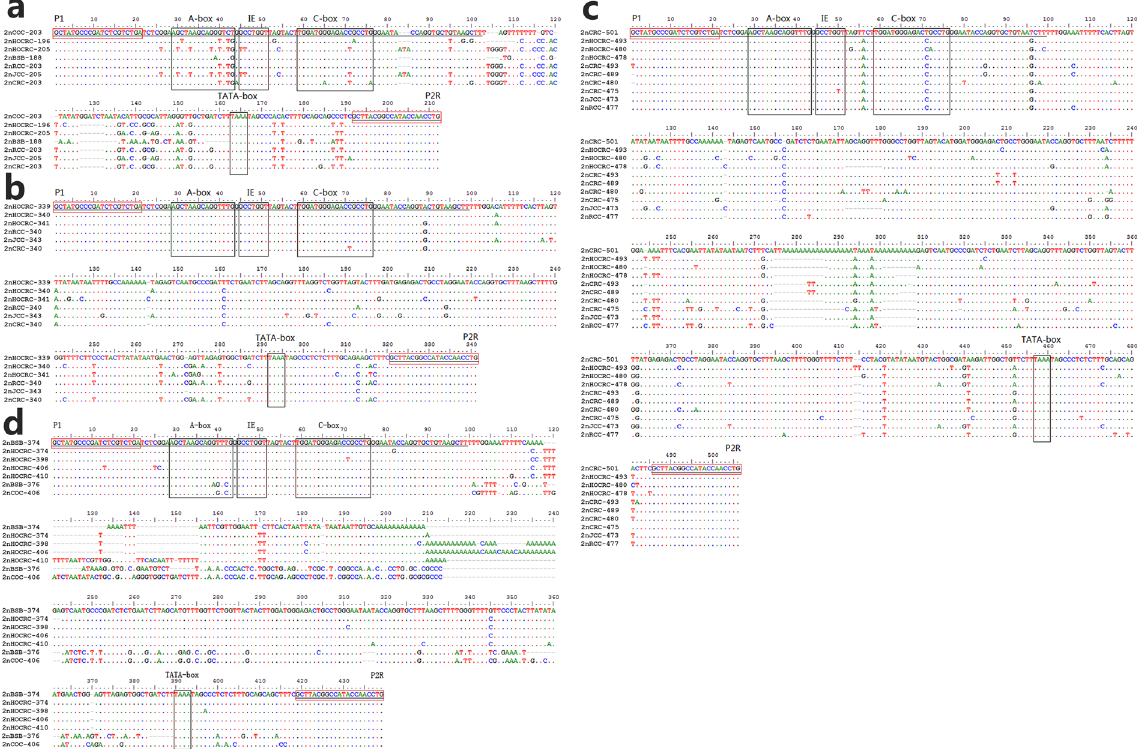
Figure 4. Nucleotide sequence alignment of sequenced 5S rDNA fragments in 2nNCRC, 2nCOC, 2nBSB, 2nCRC, 2nRCC, and 2nJCC. ( a ) Nucleotide sequence alignment of 5S rDNA fragments (class-I). ( b ) Nucleotide sequence alignment of 5S rDNA fragments (class-I-V 1 ) between 2nNCRC, 2nCRC, 2nRCC and 2nJCC. ( c ) Nucleotide sequence alignment of 5S rDNA fragments (class-I-V 2 ) between 2nNCRC, 2nCRC, 2nRCC and 2nJCC. ( d ) Nucleotide sequence alignment of 5S rDNA fragments (class-II-V 1 ). The 5S rRNA gene coding region is underlined. The regulatory sequences [A-box (AGCTAAGCAGGGTCG/AGCTAAGCAGGTTTG), intermediate element (GCCTGGT), C-box (TGGATGGGAGACCGCCTG) and TATA-box (TAAA)] are shown in black boxes. The PCR primers (P1 and P2R) are shown in red boxes. The dots indicate sequence identity, and the hyphens represent